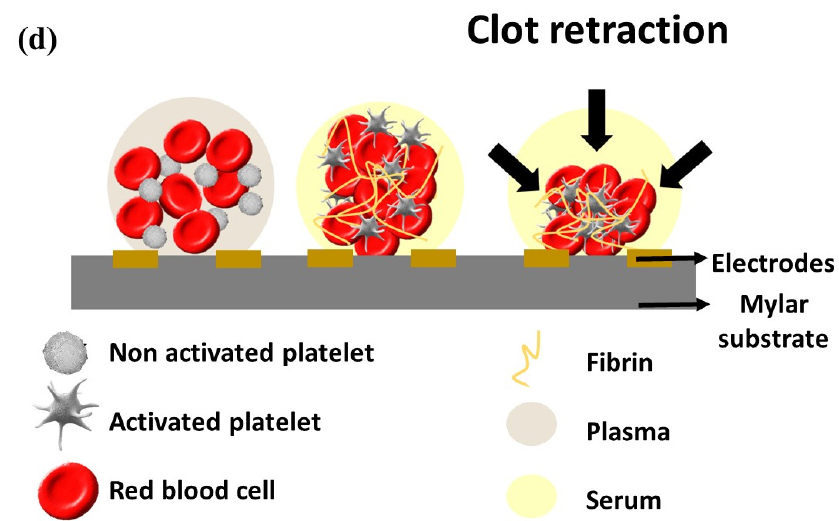
Figure 2. Time evolution of normalized impedance | Z | measured at 10 kHz for: ( a ) whole blood and recalcified blood; ( b ) retracting blood with respective picture of retracted blood clot; and ( c ) non-retracting blood with picture of non-retracted clot. ( d ) Sketch illustrating the steps occurring in clotting blood during the impedance-magnitude test.